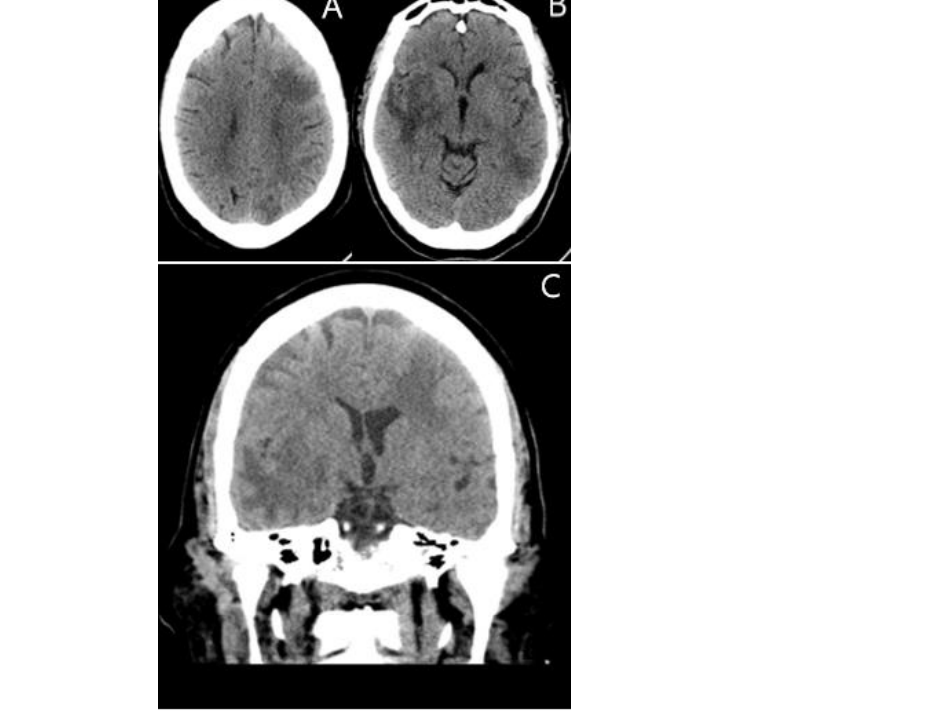
Figure 2. ( A ) Axial MRI FLAIR image demonstrating a hyperintense signal in the left frontal region left occipital and changes in a patchy manner occurring bilaterally. ( B ) There is a vasogenic edema and mass effect within the anterior right temporal lobe and a posterior left temporal lobe involving the left temporal stem and mesial temporal lobe.